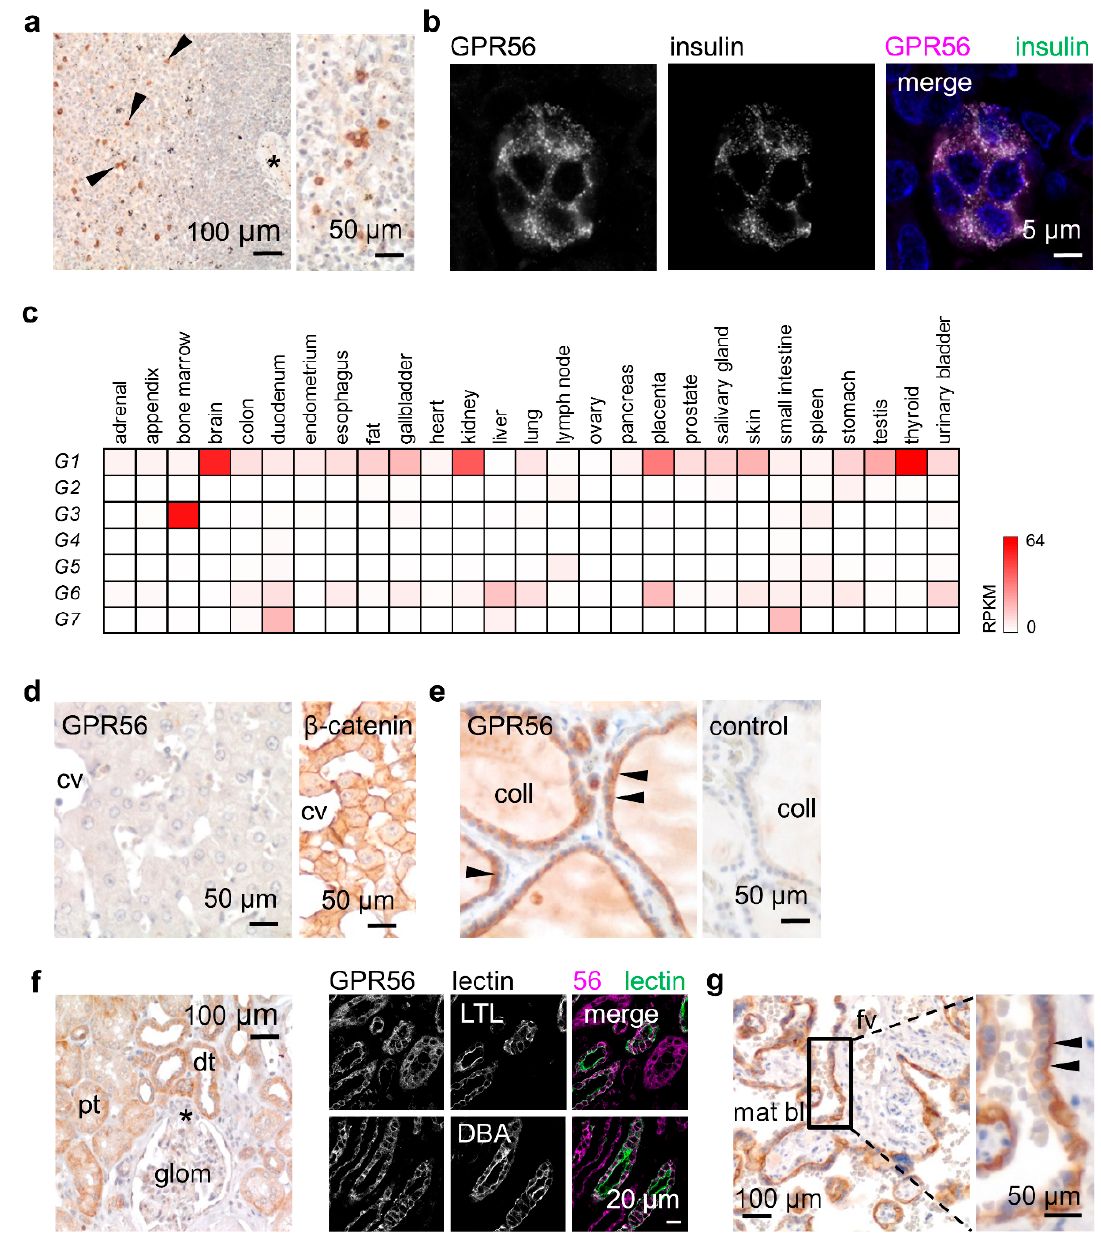
Figure 3 . ADGRG1 and GPR56 expression correlate well in normal human tissues. ( a , b , d – g ) Immunostained paraffin sections using the GPR56 NTF4 Ab. ( a ) In the spleen, GPR56-positive cells, likely cytotoxic T cells, are located in the mantle zone (arrowheads); *, white pulp artery. ( b ) In pancreatic islets, GPR56 and insulin co-localize in β -cells; double-immunofluorescence. ( c ) Transcriptomic profile of adhesion GPRCs of the G subfamily ( ADGRG1-G7 ) in normal human tissues, bulk RNA-sequencing data [20], reads per kilobase exon per million mapped reads (RPKM) are given. ( d ) The liver is GPR56-negative confirming the ADGRG1 data ( c ). β -catenin was stained as a positive control (cv central vein). ( e ) The thyroid showed the highest ADGRG1 levels ( c ). Thyrocytes (arrowheads) are strongly GPR56-positive (coll colloid); staining is attenuated at the apical side. ( f ) Kidney tubules express GPR56. Left: pt proximal and dt distal tubules; *, vascular pole of the glom glomerulus. Right: Double-immunofluorescence labeling of GPR56 and tubule-specific lectins. Lotus tetragonolobus lectin (LTL) binds to proximal tubules, Dolichos biflorus agglutinin (DBA) to distal tubules. ( g ) In a full-term placenta (mat bl maternal blood, fv fetal vessel), GPR56 appeared attenuated at the basal side of the syncytiotrophoblast (arrowheads).